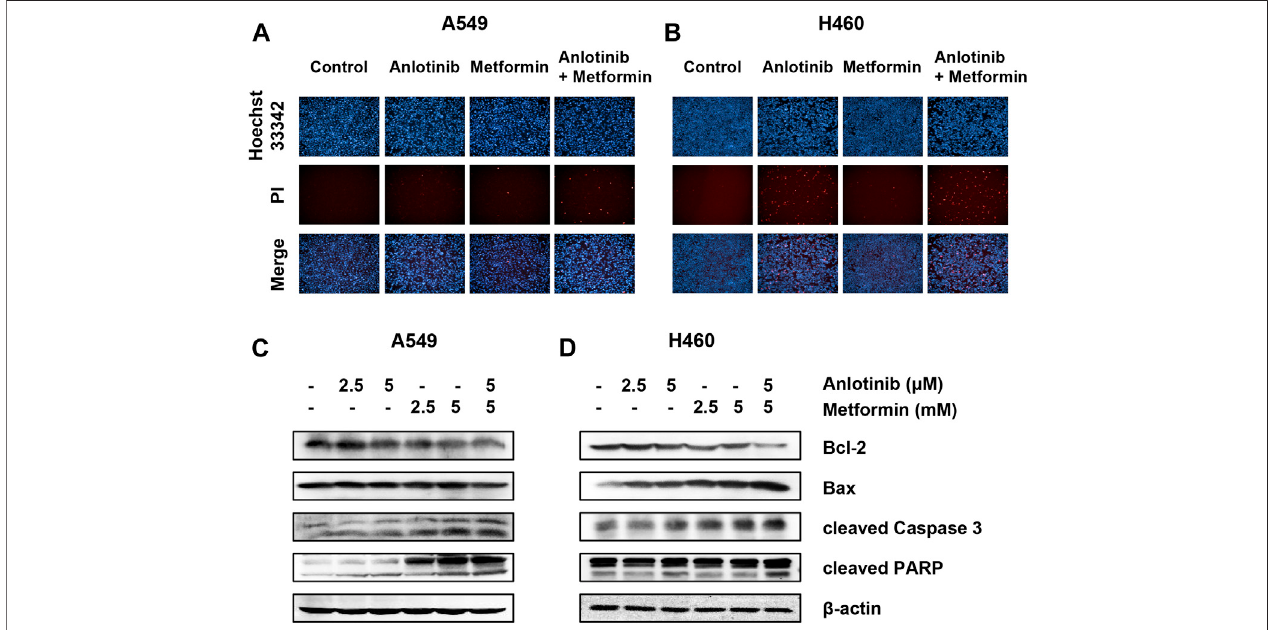
FIGURE 3 | Anlotinib with metformin synergistically induces apoptosis. A549 (A) and H460 (B) cells were incubated with anlotinib (10 μ M), metformin (10 mM), or both for 24 h. After Hoechst 33342 (bright blue color) and PI (red color) double staining, the morphological changes in cells undergoing apoptosis and necrosis were observed under a fl uorescence microscope. A549 (C) and H460 (D) cells were treated with the indicated concentrations of anlotinib, metformin, or both for 24 h. Cell lysates were immunoblotted with antibodies against Bcl-2, Bax, cleaved caspase 3, and